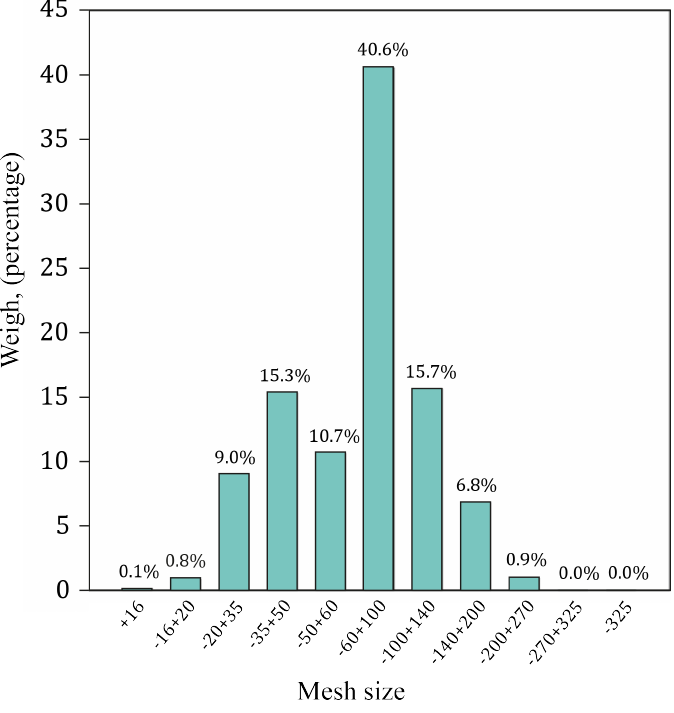
Figure 6. Grain size distribution of alluvial gold mining